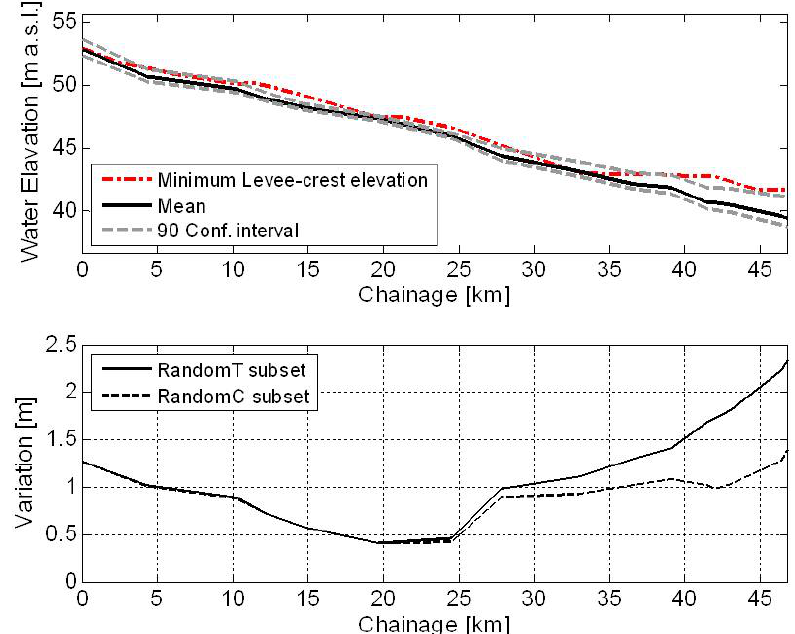
Fig. 6. Monte Carlo simulations; upper panel: range of variation (grey dashed line) and median (black line) water elevation profiles simulated for the RandomT subset along the Po River, compared with the minimum dike-crest elevation (red dashed line). Lower panel: water depth variability simulated along the Po River for RandomT (black line) and RandomC (dashed line)